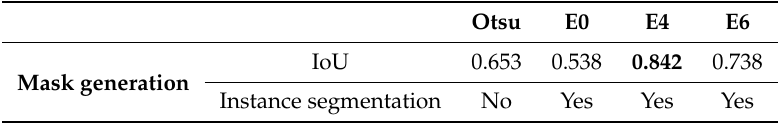
Table 1. Mask generation accuracy with traditional blob detection method. The IoU was computed against a small ground truth mask set. E0, E4, E6 represent the number of erosion pixels are 0, 4 and 6 respectively. E4 masks are used later for training Mask RCNN.